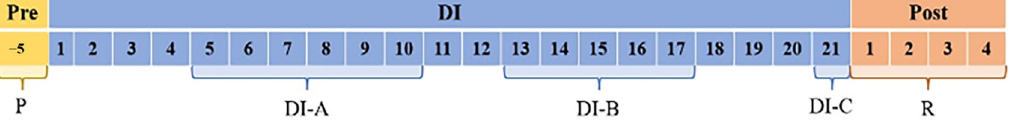
Figure 4. Experiment unfolding during 21-day immersion.